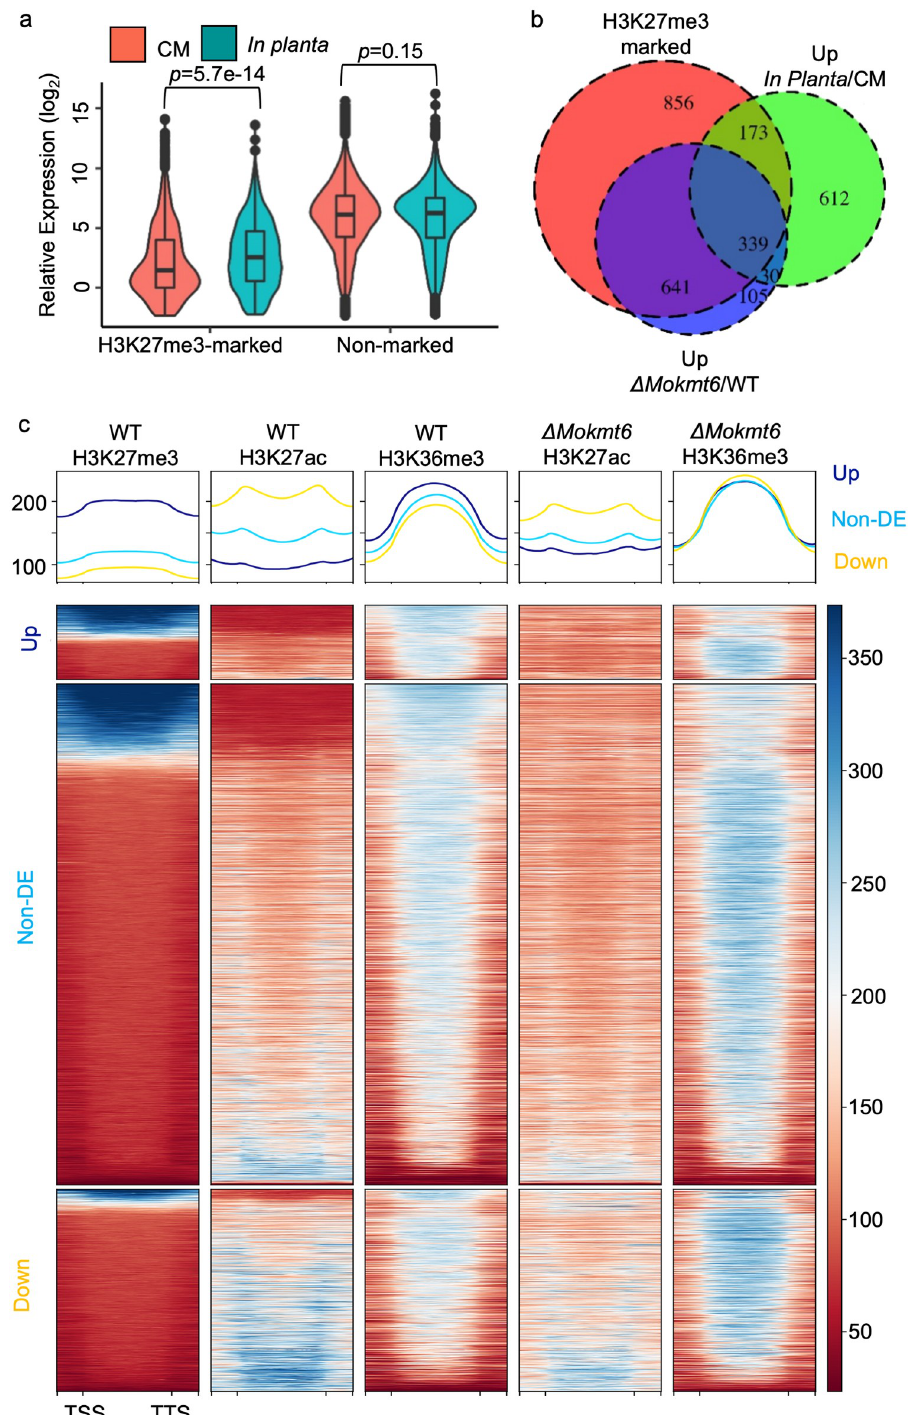
Fig 5. H3K27me3 marked genes are enriched for in planta induced genes. (A) Violin plots showed H3K27me3 marked genes identified in Guy11 wild type (WT) grown in complete medium (CM) are significantly upregulated in planta . (B) Venn diagram illustrating the enrichment of H3K27me3 marked genes in upregulated genes in planta and in mutant Δ Mokmt6 abolishing H3K27me3. (C) Heatmaps visualizing ChIP signals for H3K27me3, H3K27ac and H3K36me3 across differential expressed gene sets identified by comparison of relative gene expression from wild type growing in planta and liquid complete medium.